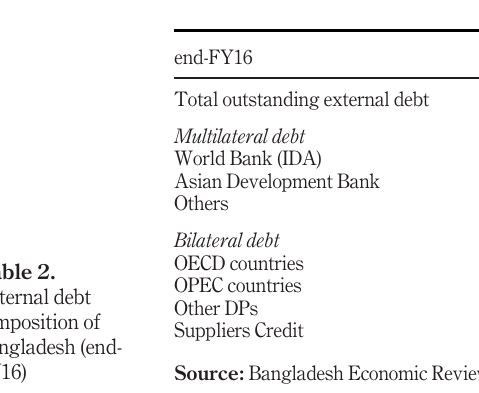
Figure 2. Debt as percentage